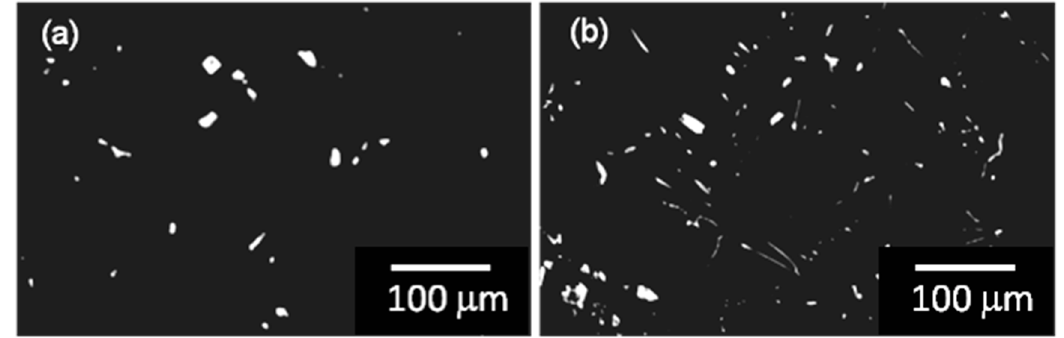
Figure 8. FESEM micrograph of alloys aged for 72 h: ( a ) Mg-4Al-1Nd and ( b ) Mg-4Al-4Nd alloy.